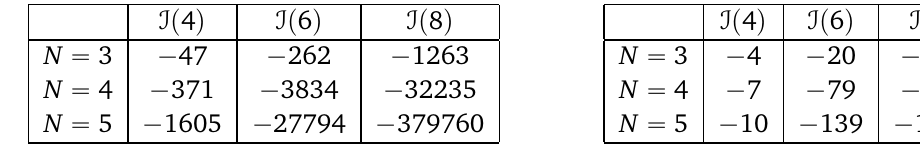
Table 2: The first few indices for the flag sigma model U p N q without imposing any discrete symmetry, and on the right are indices while imposing ˆ (cid:90) the S symmetry. The indices are all negative, which means that our counting N 2 analysis does not predict higher-spin quantum conserved